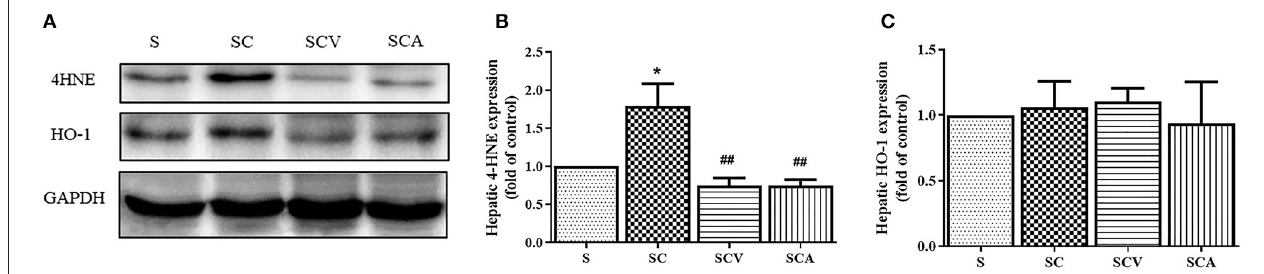
FIGURE 6 | Coconut vinegar supplementation reduced hepatic lipid peroxidation. (A) The band of glyceraldehyde 3-phosphate dehydrogenase (GAPDH), 4-hydroxynonenal (4-HNE), and Heme oxygenase-1 (HO-1) expressions of hepatic tissues, the proteins expression was determined by western blot analysis in five